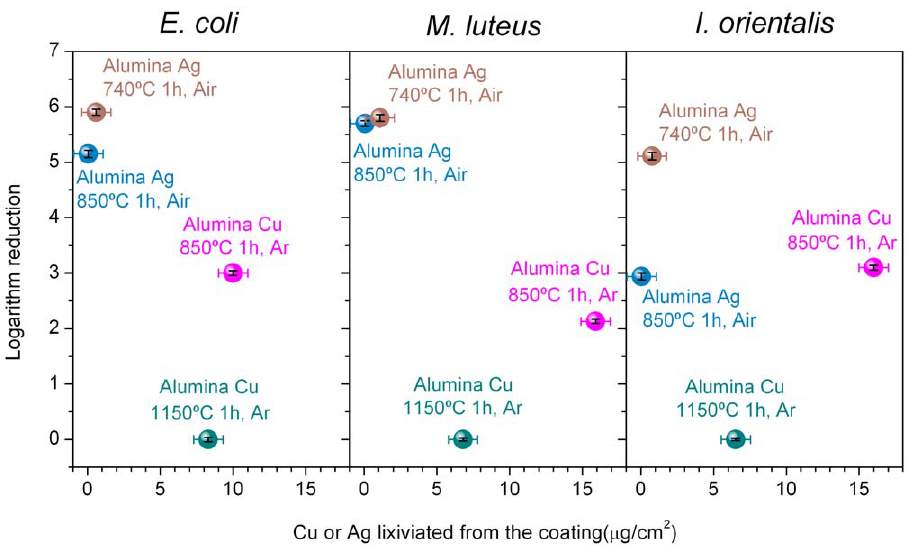
Figure 4. Logarithm of reduction of E.coli , M.luteus and I.orientalis for the coatings versus the total of silver or copper lixiviated per area